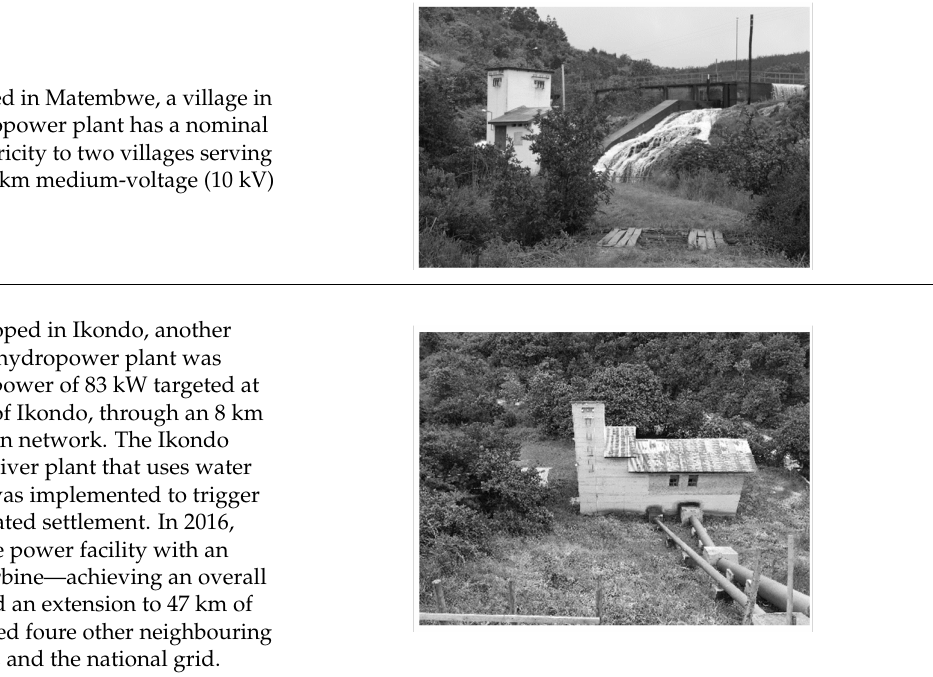
Table 1. Hydroelectric plants implemented by CEFA in the Njombe region of